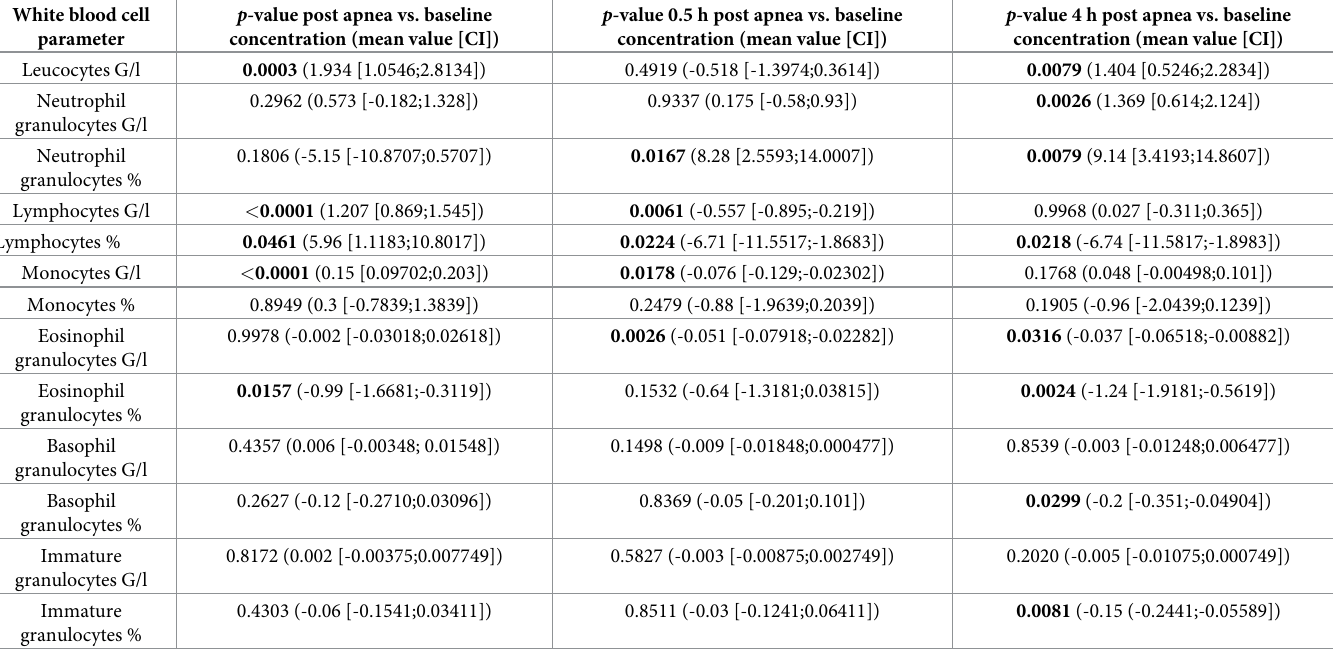
p -values, mean values and confidence intervals (CI) for change for the differences between the three time intervals post apnea, 0.5 h and 4 h post apnea versus baseline concentrations for leucocytes, neutrophil granulocytes, lymphocytes, monocytes, eosinophil granulocytes, basophil granulocytes and immature granulocytes. Significant p -values are marked in